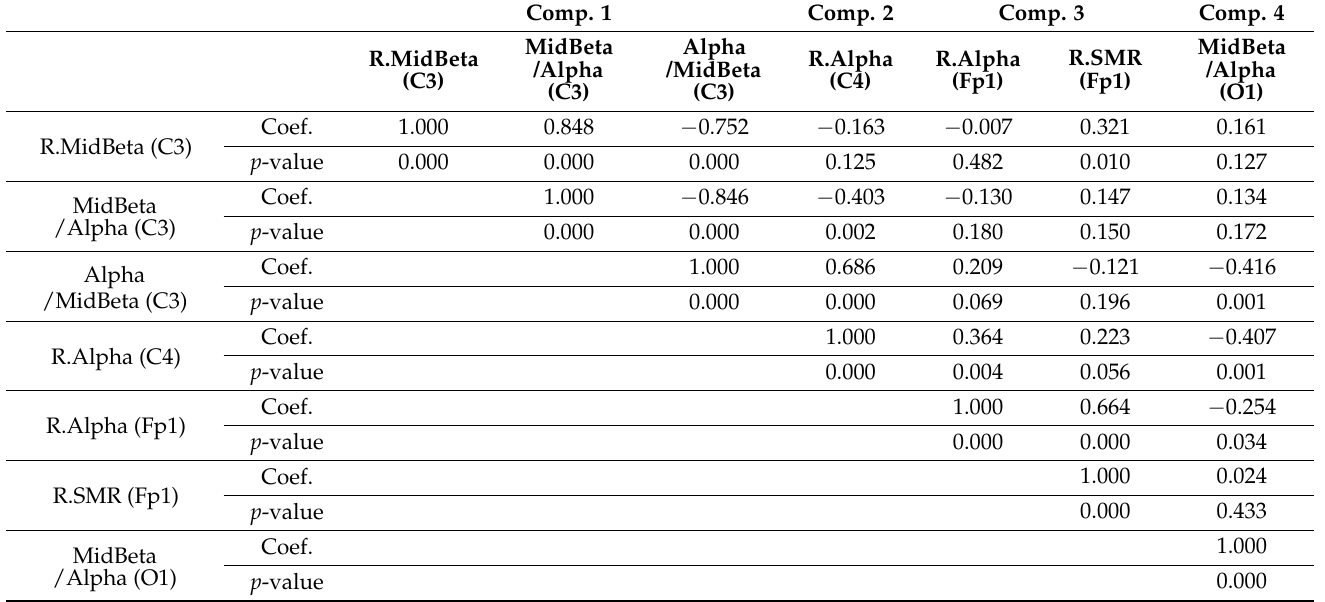
Table 5. Correlation coefficients of seven parameters.